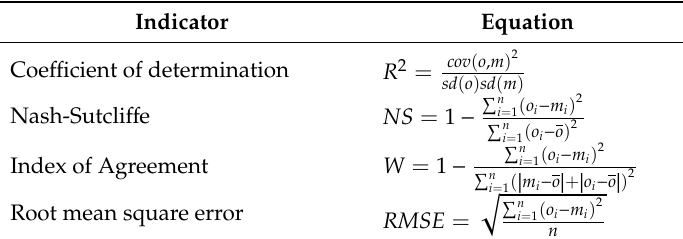
Table 2. Equations and indicators to validate the